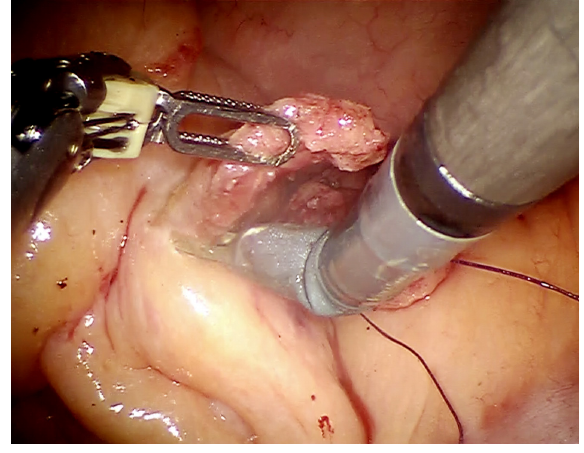
Figure 2. Peritoneal incision exposing the right ureter at the level of iliac crossing.